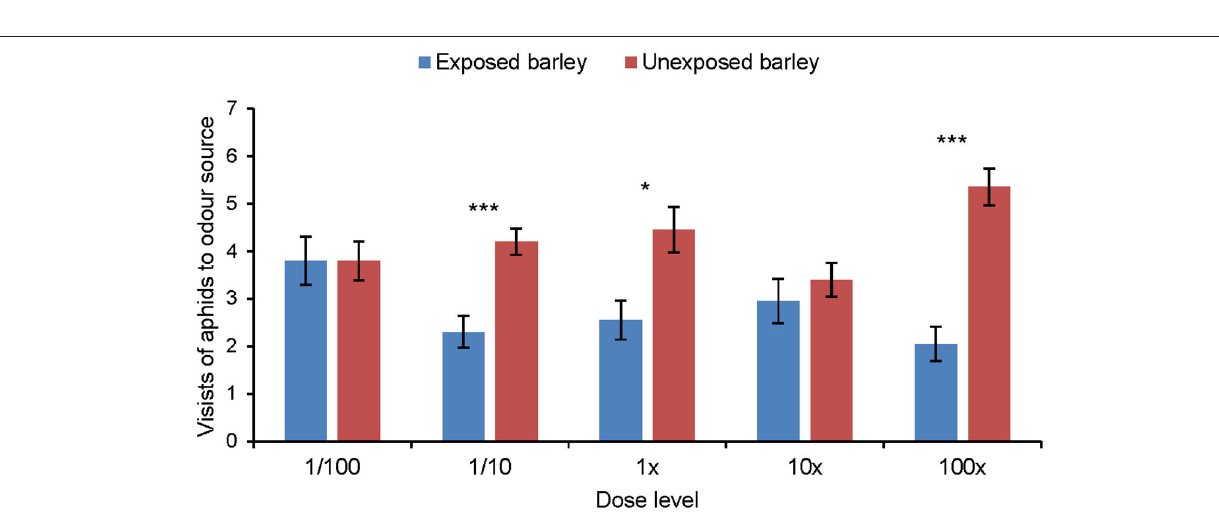
(Hardie et al., 1994).The current results suggest that the